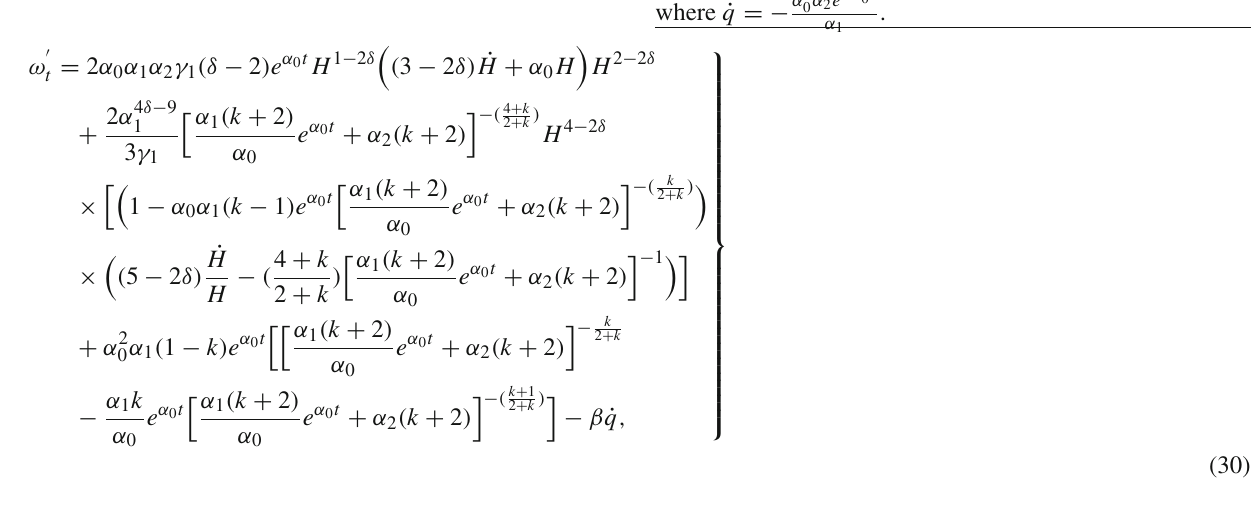
Fig. 10 Plot of ω T versus ω (cid:2) γ = 101, and β = − 0 . 1 1